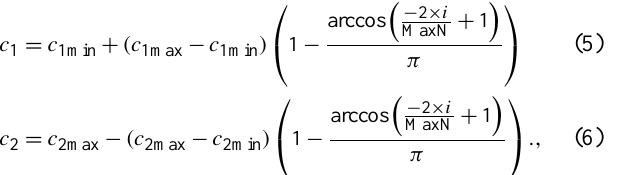
Table 1. Initial values of land-use-based parameters in Tiantoushui